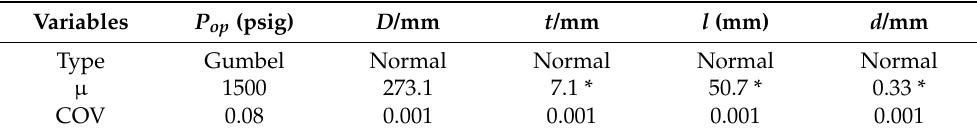
Figure 9. ( a ) Distribution of burst pressure for each defect; ( b ) Probability of Failure. The pipeline parameters were unavailable in the original dataset; therefore, the user- defined values were obtained from the literature [18] as per Table 4 below. Table 4. Probabilistic models of the random variables